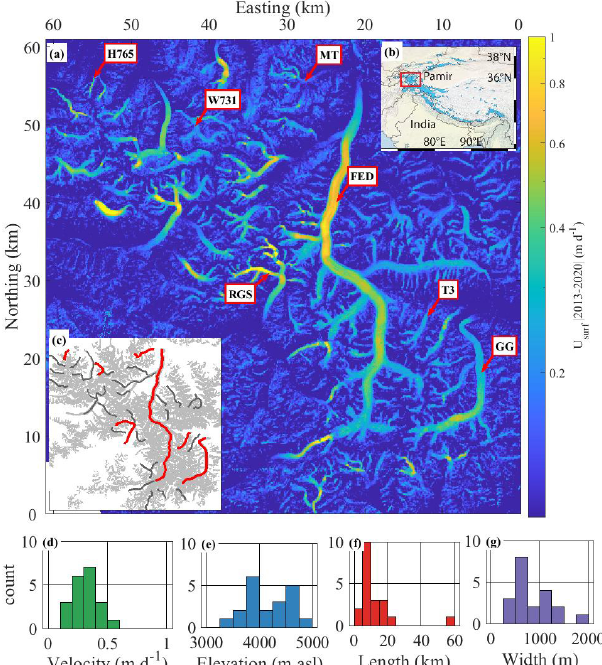
Figure 1. (a) Glacier velocity (md − 1 ) mosaic of the western Pamir mountain range, averaged (median) over the time period 2013– 2020. Velocity is obtained at a horizontal resolution of 40m us- ing 650 pairs of Sentinel-2 images and 400 pairs of Landsat 8 im- ages (see the “Materials and methods” section for details). Color bar is coded on a logarithmic scale going from blue (no displace- ment) to yellow (fast displacement). Text boxes show the names (based on Randolph Glacier Inventory, 2017) of the seven glaciers investigated in detail: the Fedchenko Glacier (FED); the Tanymas 3 Glacier (T3); the Grumm-Grzhimaylo Glacier (GG); the Rus- sian Geographical Society Glacier (RGS); the Walter 731 Glacier (W731); the Hadyrsha 765 Glacier (H765); Malyy Tanymas Glacier (MT). All of these glaciers flow northward, except for RGS, which flows southward. (b) Location of the western Pamirs in the regional context; blue areas show glacier coverage (Randolph Glacier Inven- tory, 2017); background shaded relief provided by ASTER (2019). (c) Glaciated area (gray), flowlines (red) of the seven glaciers pre- viously mentioned and the flowlines (dark gray) of 31 additional glaciers investigated. (d, e, f, g) Characteristics of the studied 38 glaciers, in terms of median velocity, median elevation, length and median width. Easting and northing are relative to 38.39 ◦ N, 72.63 ◦ E in the UTM 32N